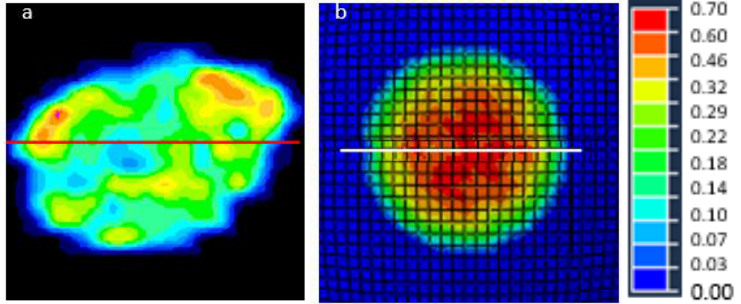
Figure 19. Layers and surface pressure distributions of the real ( a ) and model ( b ) object for an apple dropped on a wooden substrate from a height of 30 mm in the cross-section passing through the central point of contact.